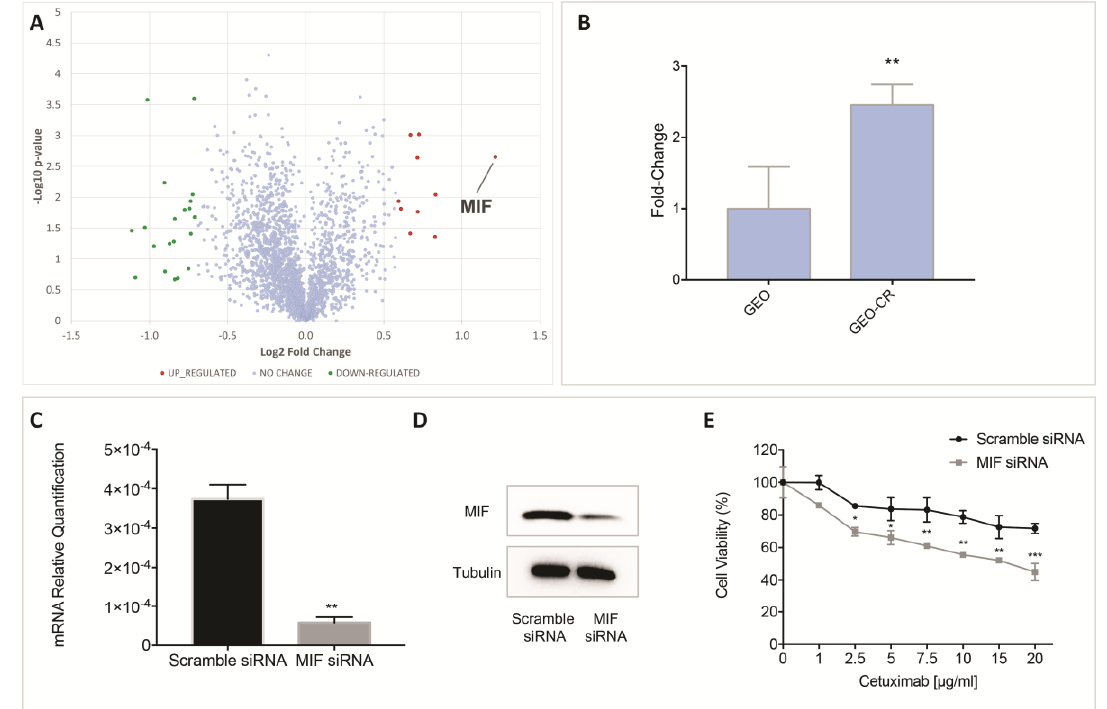
Figure 2. ( A ) Volcano plot obtained from TMT-based quantitative proteomics analysis of GEO-CR versus GEO cell lines. Each point represents the difference in expression (Log2 fold-change) between the cetuximab-resistant and sensitive GEO cell lines plotted against the − Log10 p -value. Identified proteins with no changes in their regulation level are reported in light blue. Up- and down-regulated proteins (fold change ≥ 1.5) are indicated in red and green, respectively. Differentially expressed proteins are reported in Table 1. ( B ) qRT-PCR analysis of MIF mRNA in GEO and GEO-CR cells. bars , standard deviation (SD); values are expressed as mean of four replicates (** p ≤ 0.01; Unpaired t test). ( C ) Targeted silencing of MIF gene expression by small interfering RNA (siRNA). Results of qRT-PCR